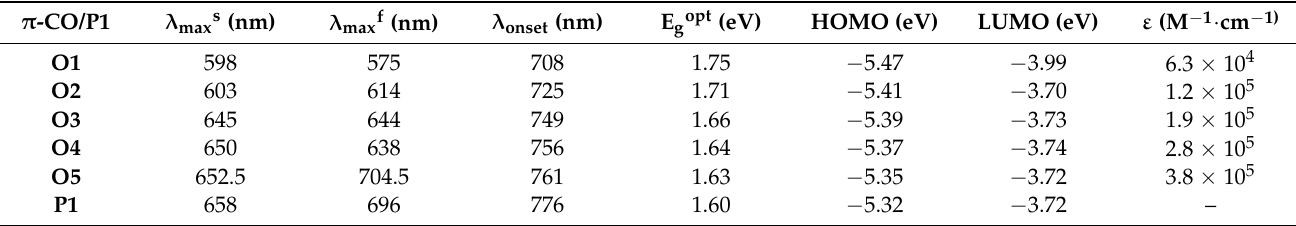
Table 1. Key opto-electrochemical property data of O s1~5 and P